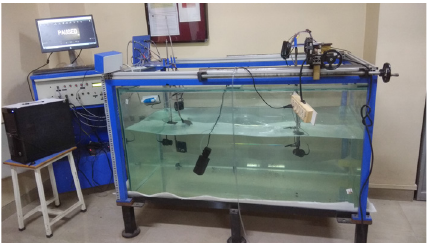
Figure 3. Tank setup